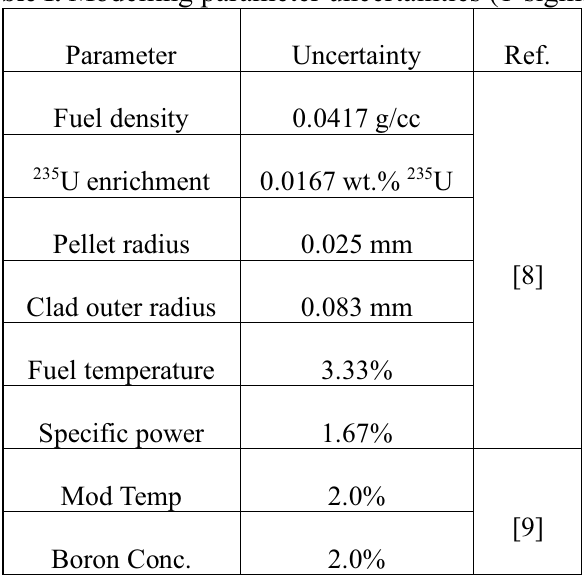
Table I. Modelling parameter uncertainties